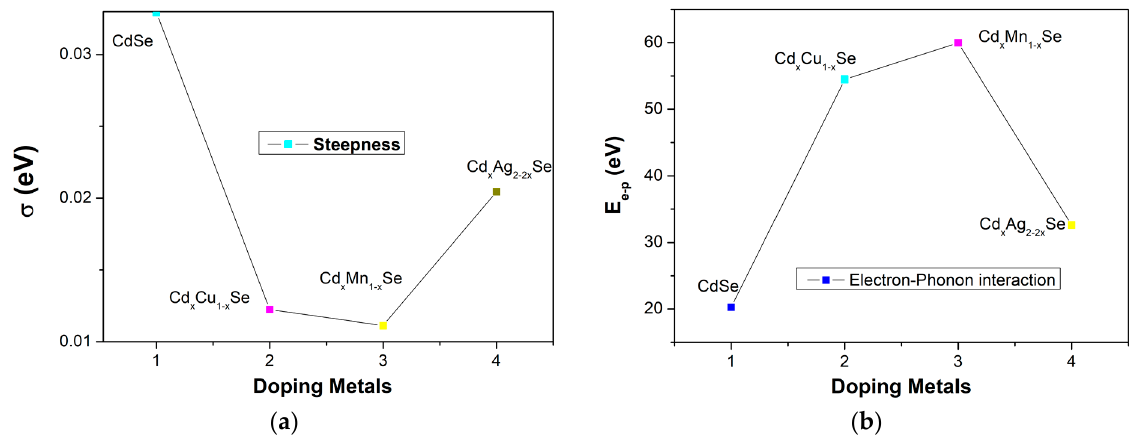
Figure 5. The dependence of ( a ) σ and ( b ) E e-p in metal addition in films.